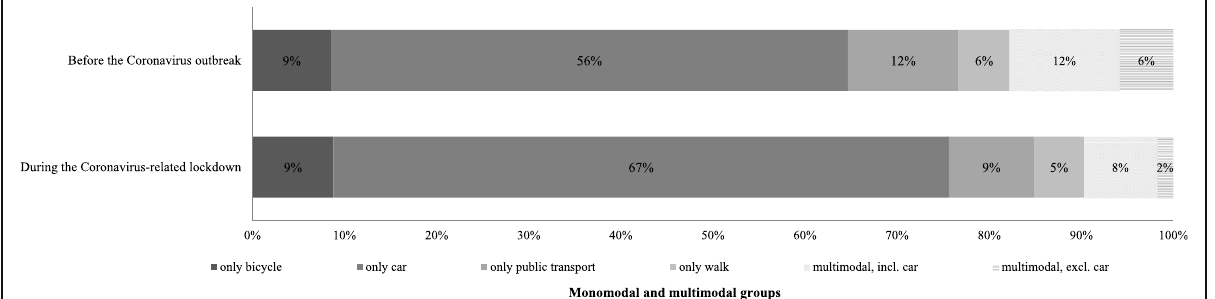
Fig. 7 Usage patterns of different modes of transportation before the Coronavirus pandemic and during the Coronavirus-related lockdown for commuting trips (only people who had a regular commuting trip before the pandemic and still have one during the lockdown, n =